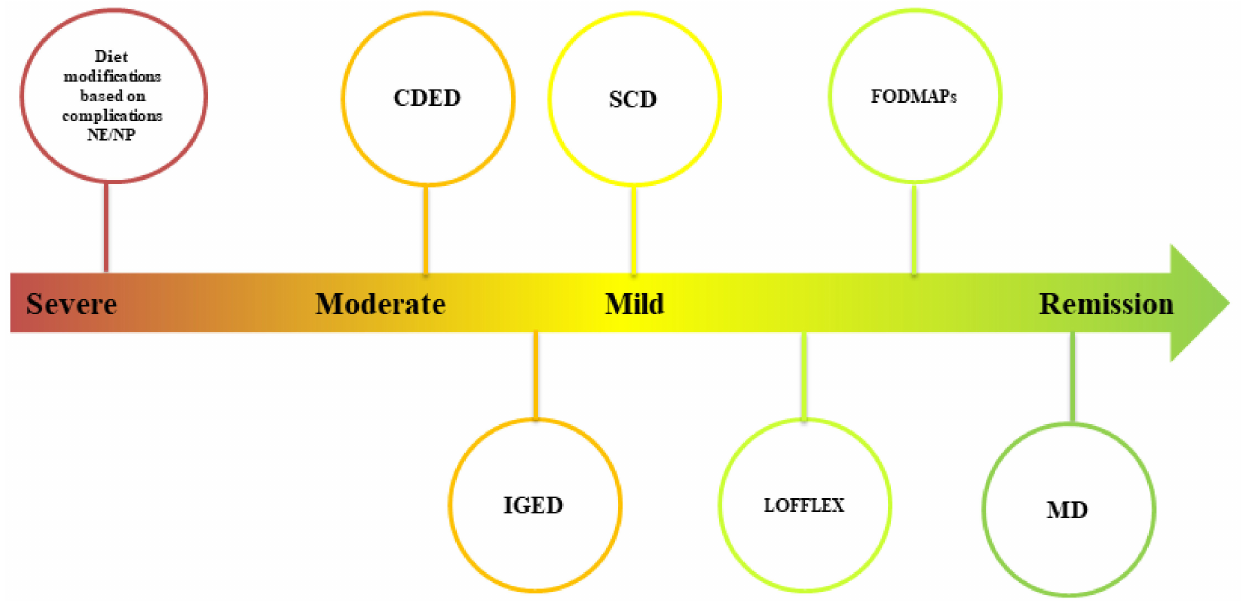
Figure 2. Potential therapeutic indications for specific diets based on disease severity. NP: parenteral nutrition; NE: enteral nutrition; CDED: Crohn’s Disease Exclusion Diet, IGED: Immunoglobulin Exclusion Diet; SCD: Specific Carbohydrate Diet; LOFFLEX: Low-Fat Fiber Limited Exclusion; MD: Mediterranean